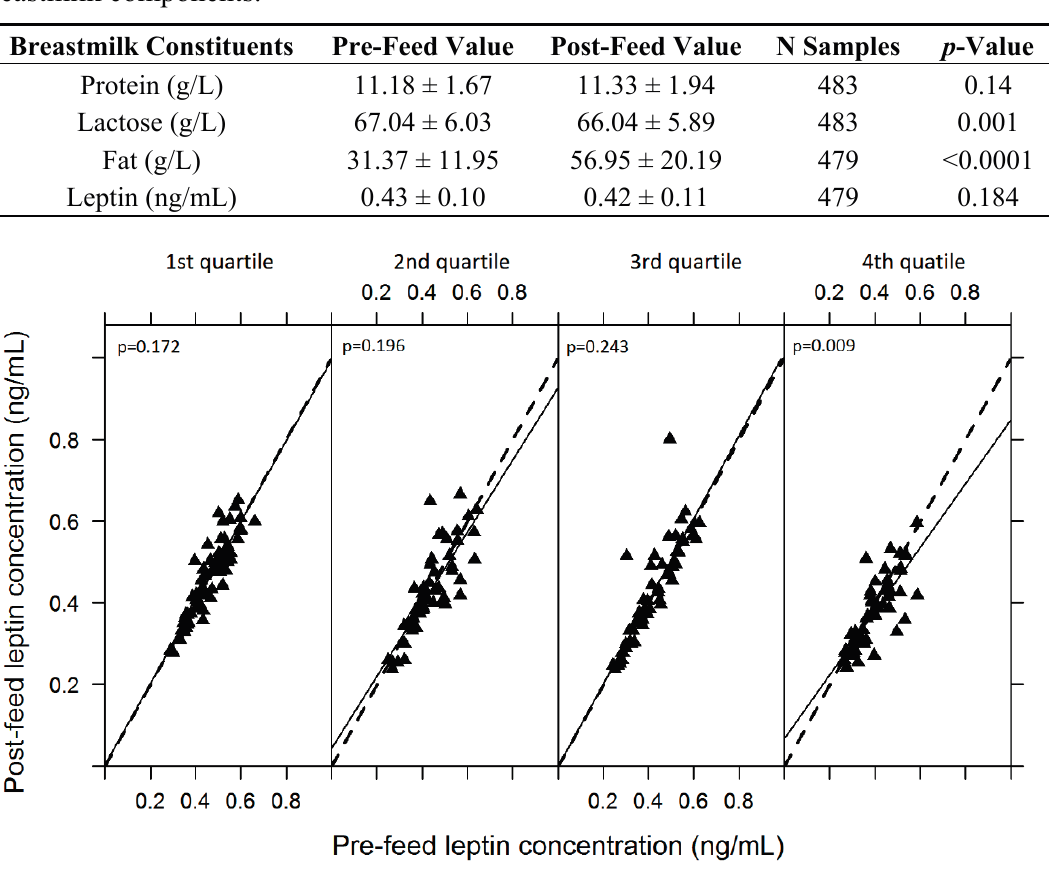
Figure 1. Relationship between the pre- and post-feed skim milk leptin levels and feed volume, where feed volumes are divided into the first quartile (0–41 g; n = 67), the second quartile (42–65 g; n = 57), the third quartile (66–105 g; n = 62) and the fourth quartile 105 g; n = 56). Regression and equivalence lines are shown in solid black and dashed lines,